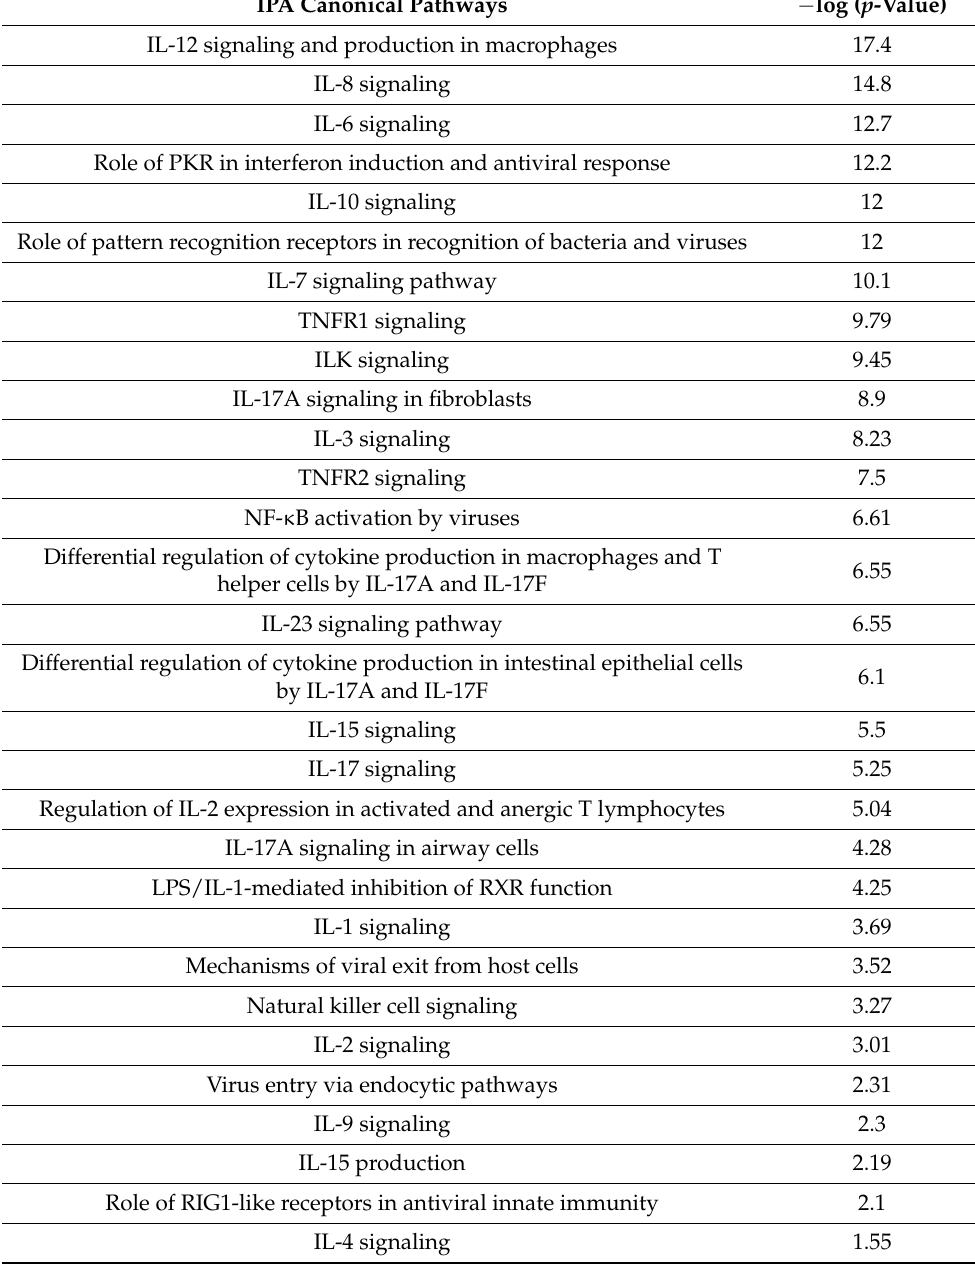
Table 2. The canonical pathway analysis by Ingenuity Pathways Analysis (IPA) §